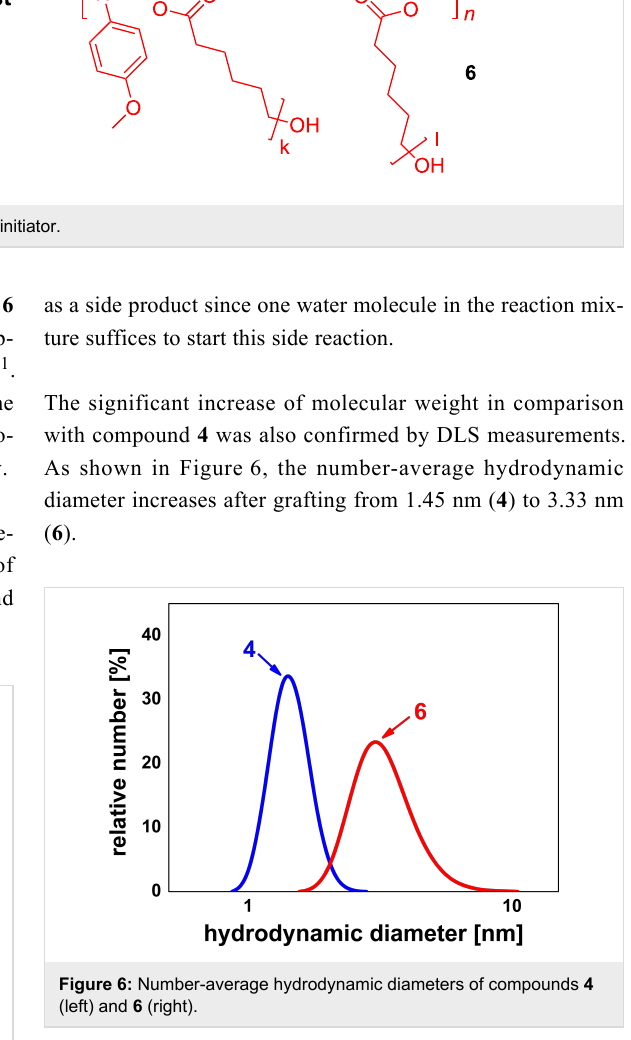
Figure 6: Number-average hydrodynamic diameters of compounds 4 (left) and 6 (right).